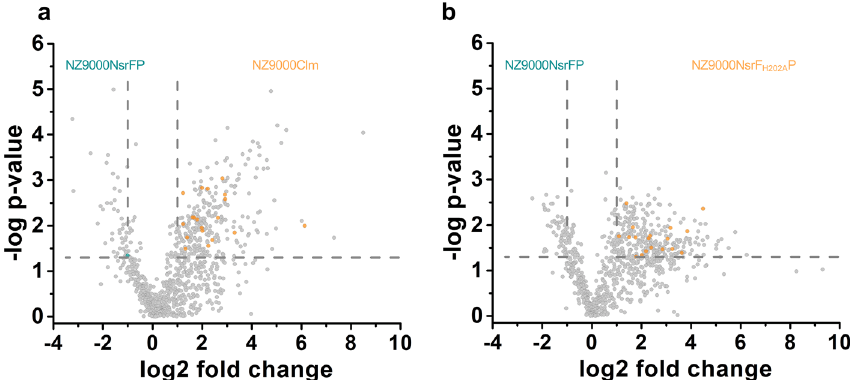
Figure 5. ( a ) Volcano plot of the proteome analysis of NZ9000 Sa NsrFP against NZ9000Cm and ( b ) NZ9000 Sa NsrFP against NZ9000 S aNsrF H202A P. Proteins involved in cell wall synthesis are highlighted in orange if upregulated in NZ9000Cm ( a ) and NZ9000 Sa NsrF H202A P ( b ) and highlighted in blue if upregulated in NZ9000 Sa NsrFP. Proteins with a p-value ≤ 0.05 and a fold change ≥ 2 were considered as statistically significant. Proteome data was plotted using GraphPad Prism 6.0 for Mac, GraphPad Software, San Diego, California USA, www. graph pad.